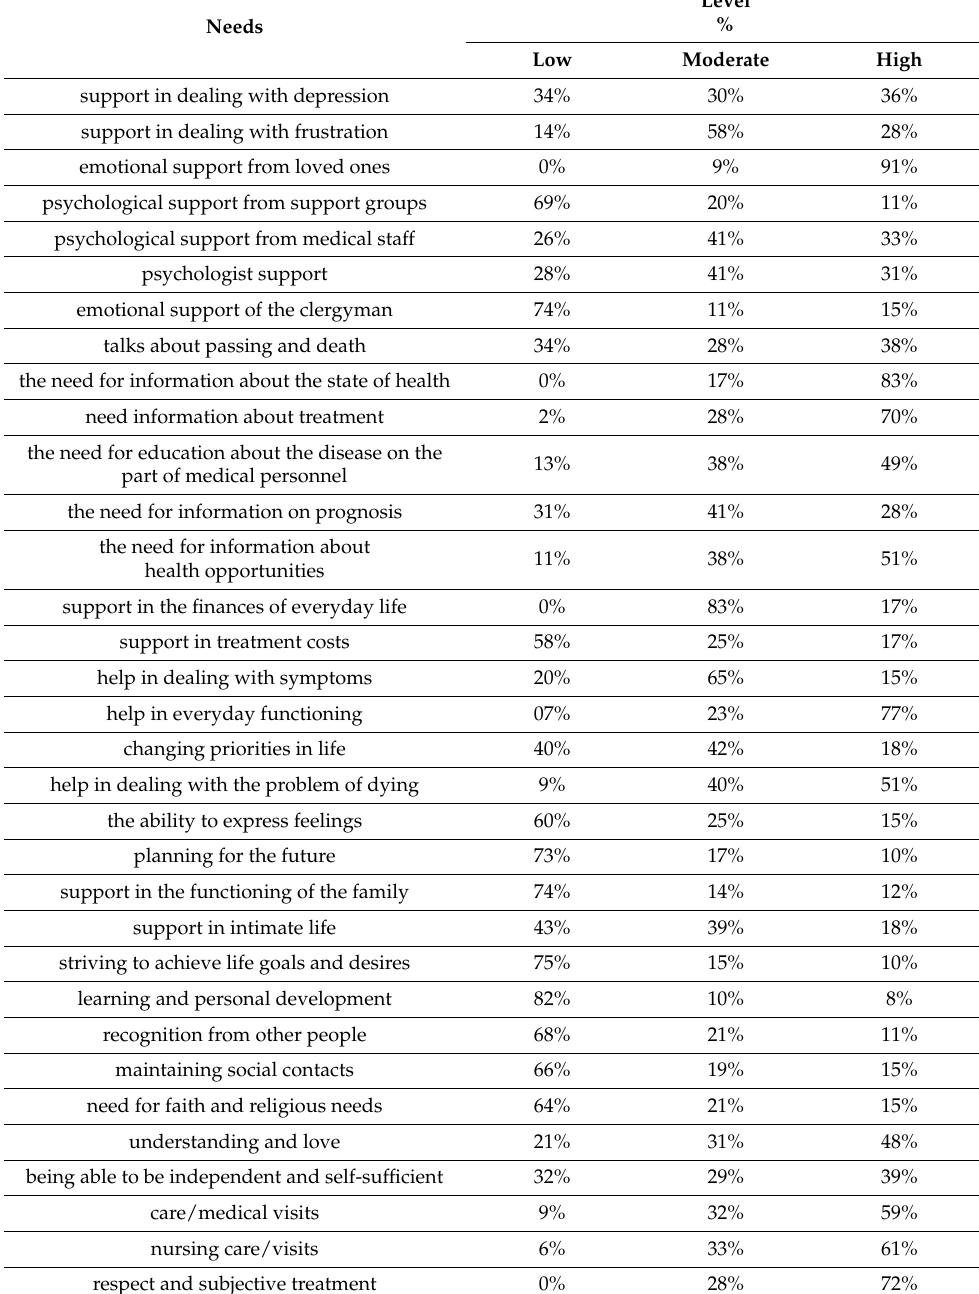
Table 3. Needs of parents by